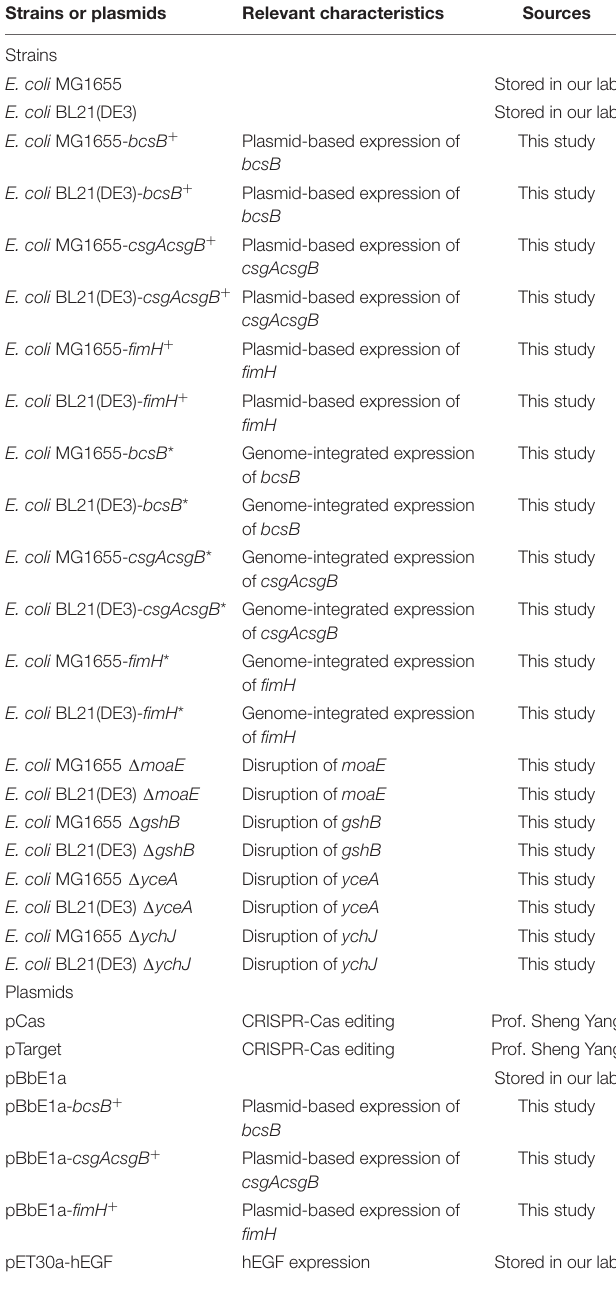
TABLE 1 | Strains and plasmids used in this